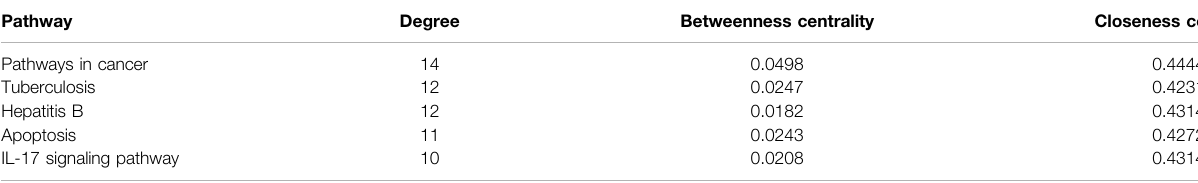
TABLE 6 | KEGG Pathway network and node characterization parameters. Pathway Pathways in cancer